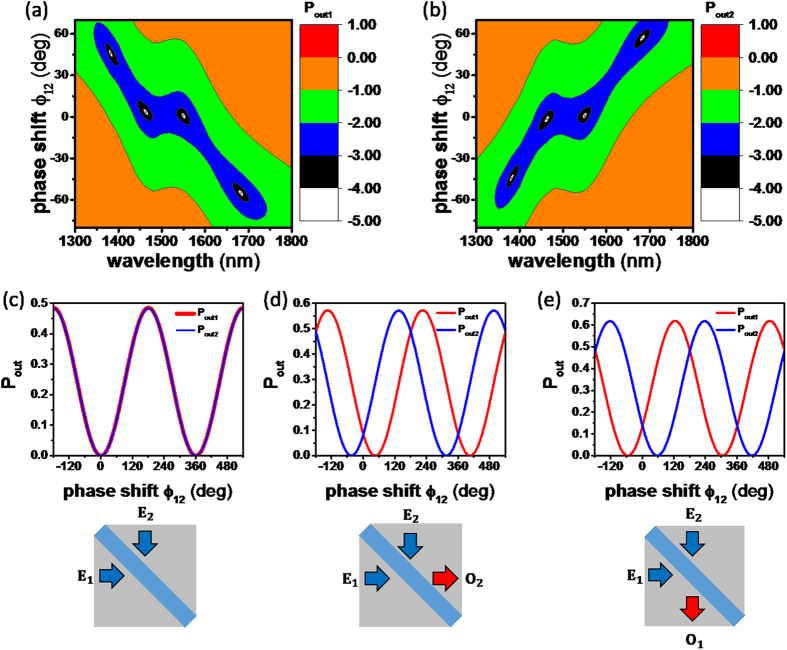
2D contour maps of (a) log(Pout1) and (b) log(Pout2) as a function of φ12. The color map is on the log scale. Optical switching of Pout1 and Pout2 at (c) 1550 nm, (d) 1381 nm, and (e) 1683 nm as a function of φ12.